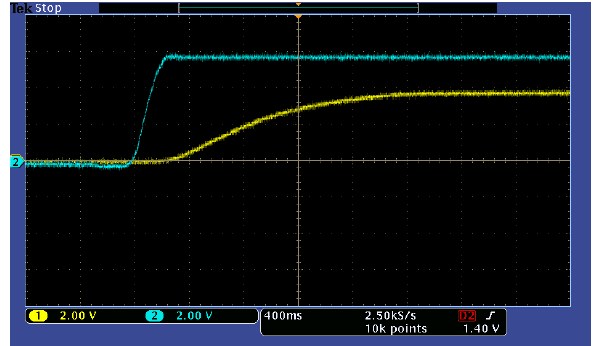
Figure 10. Input (yellow) and output (blue) waveforms, gain=1.